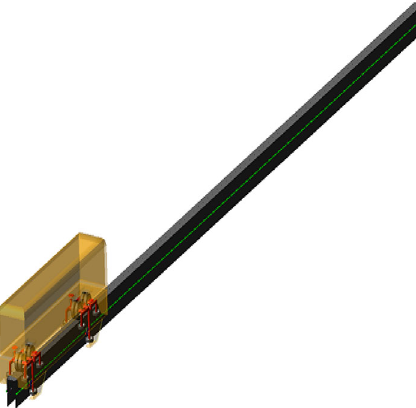
Fig. 6 Dynamic simulation model of single vehicle